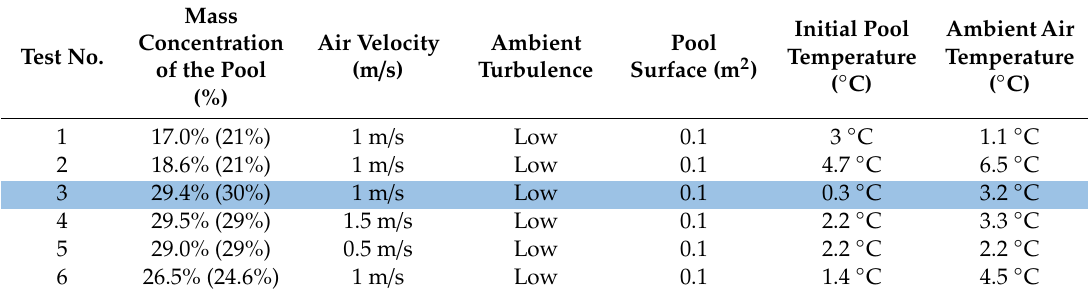
Table 1. Presentation of the small-scale tests. Concentration given by the provider is given in brackets ( ).